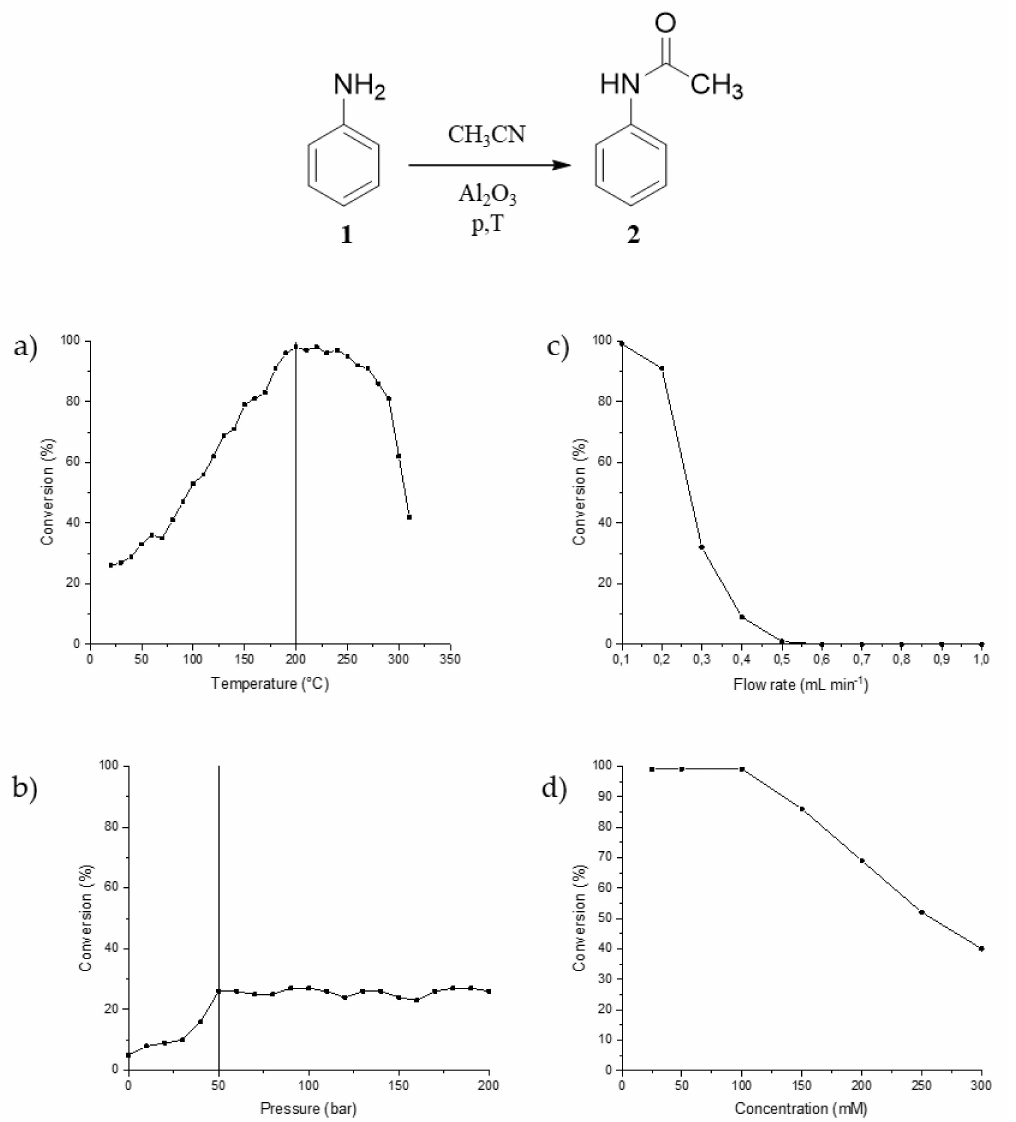
Figure 2. The e ff ect of temperature ( a ), pressure ( b ), flow rate ( c ) and concentration ( d ) on the reaction conversion catalyzed by Al 2 O 3 . The e ff ect of the pressure was measured at room temperature and the e ff ect of temperature was determined at 50 bar, while the e ff ect of the flow rate and concentration was analyzed at the optimized